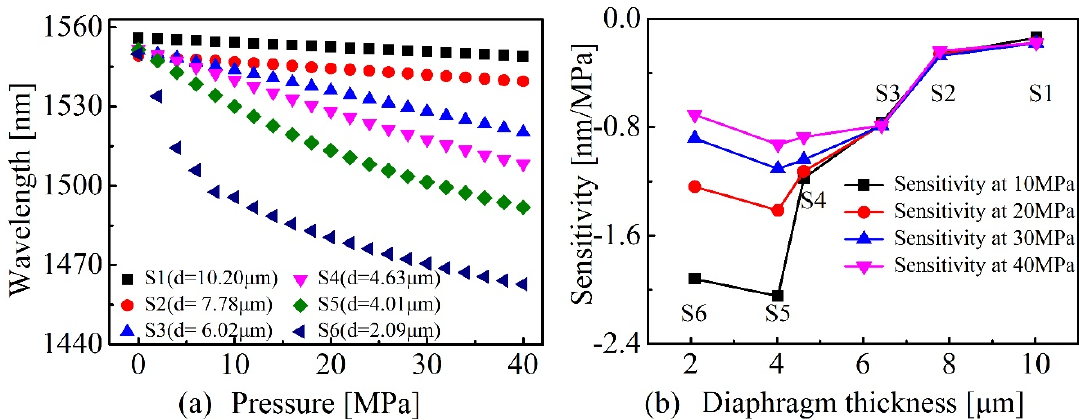
Figure 4. ( a ) The tracked dip wavelength versus applied pressure for six samples: S1 ( d = 10.20 μ m), S2 ( d = 7.78 μ m), S3 ( d = 6.02 μ m), S4 ( d = 4.63 μ m), S5 ( d = 4.01 μ m), and S6 ( d = 2.09 μ m), respectively. ( b ) Pressure sensitivities of the six sensor samples at pressures of 10, 20, 30, and 40 MPa, respectively.